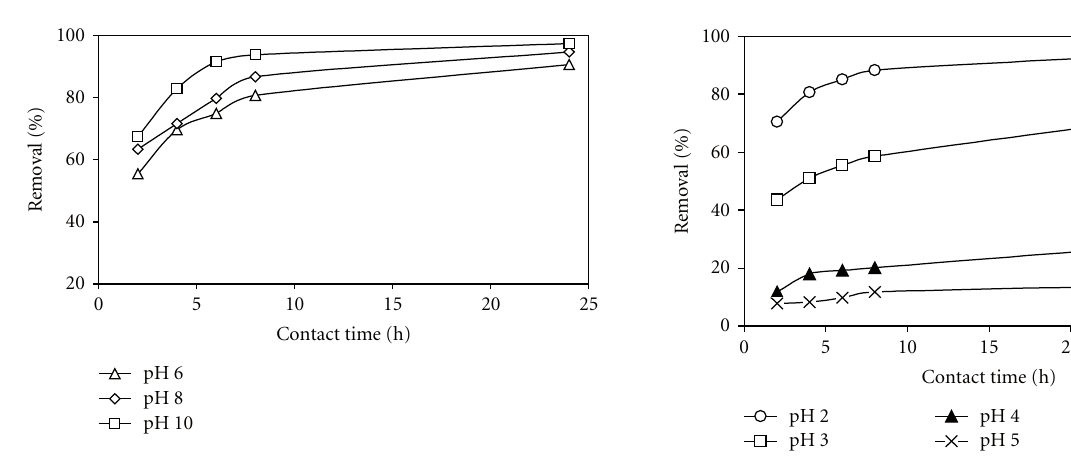
F 5: Effect of pH and contact time on basic dye removal by PC (adsorbent dosage, 500 mg per 100 mL; dye concentrations, 50mg ). L −1